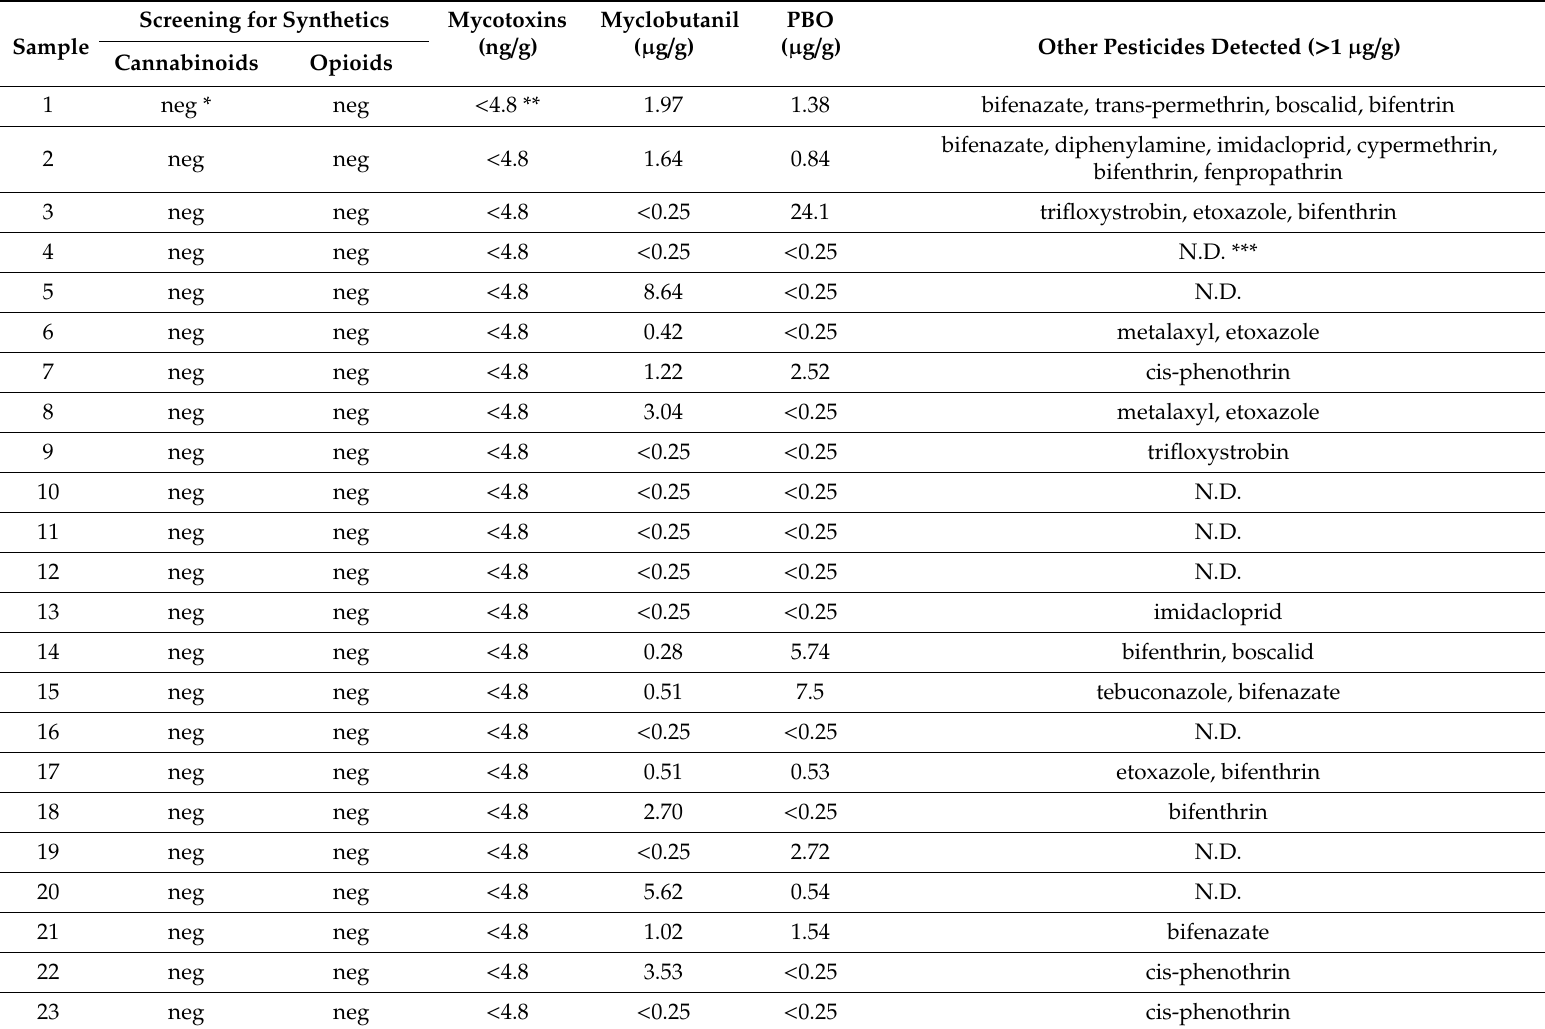
Table 2. Synthetic cannabinoids, synthetic opioids, mycotoxins, and pesticides in vaporizer fluids samples.